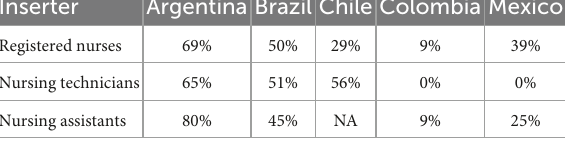
TABLE 3 Missing PIVC documentation (defined as missing insertion date, reason for insertion, or no evidence of site assessment in 24 h) by inserter